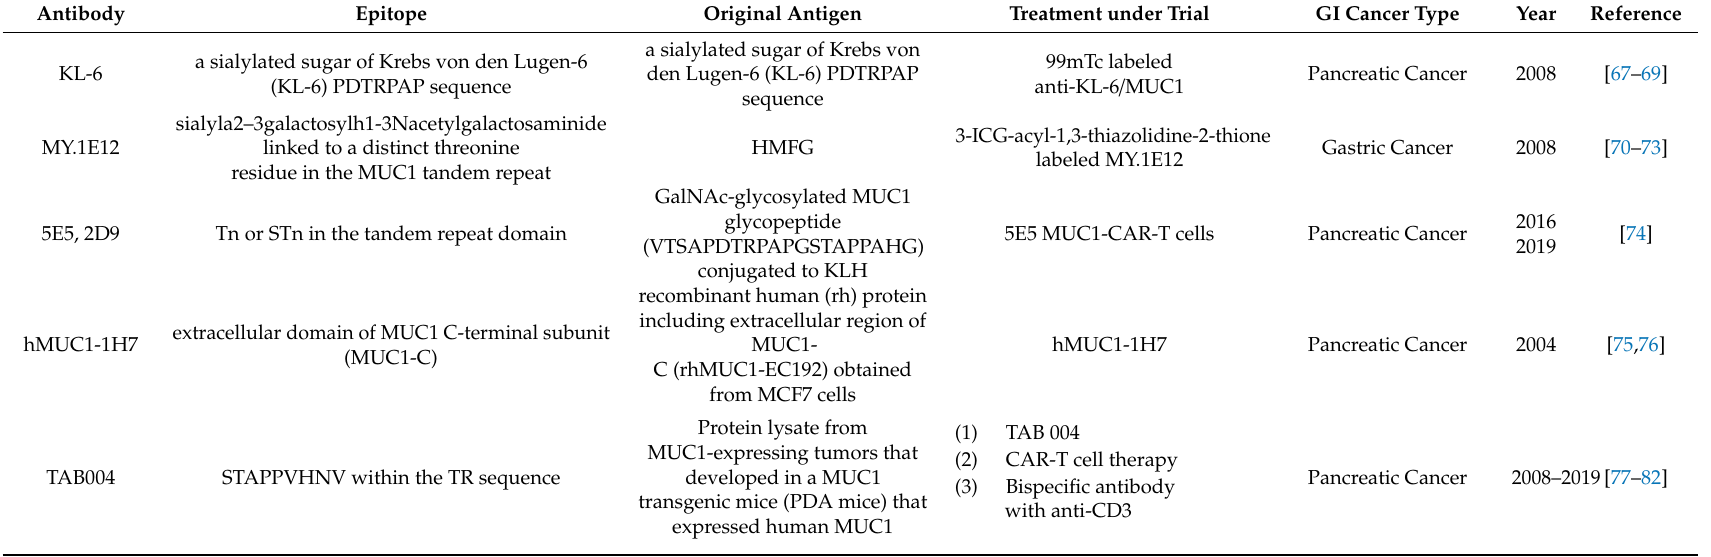
Table 1. MUC1 antibodies under preclinical trials for GI